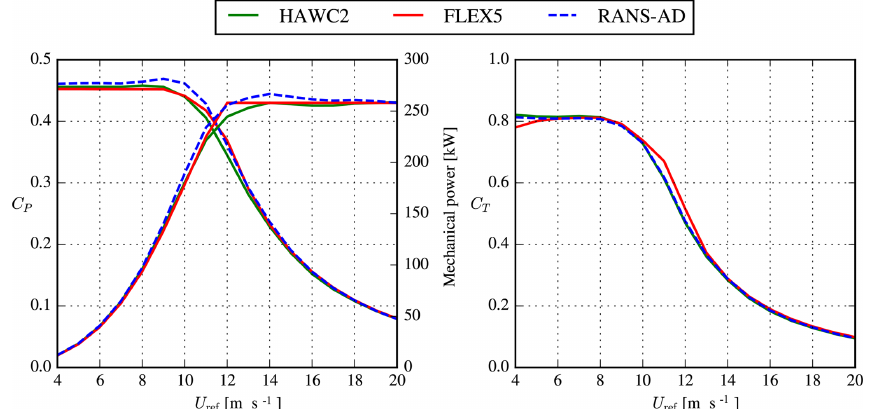
Figure 8. Comparison of simulated mechanical power and thrust of a single V29 rotor using HAWC2, FLEX5 and EllipSys3D RANS-AD.